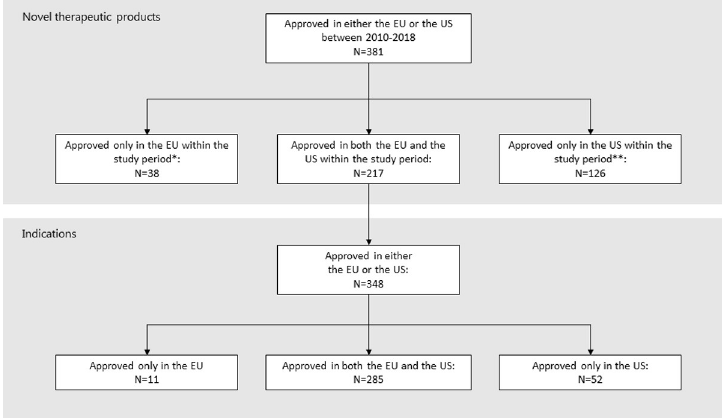
Fig 2. Selection of cohort. Flowchart of selection of the new active substances (products) included in the study and the indications for analysis.